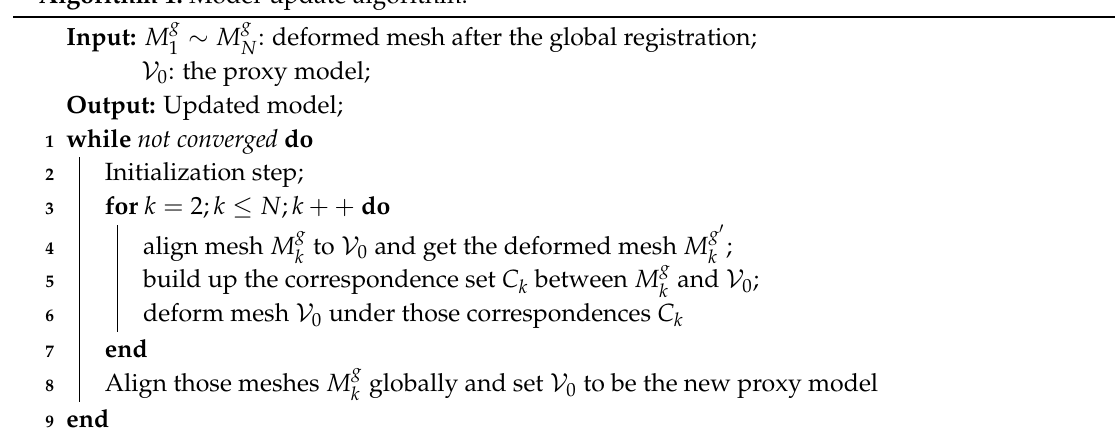
Algorithm 1: Model-update